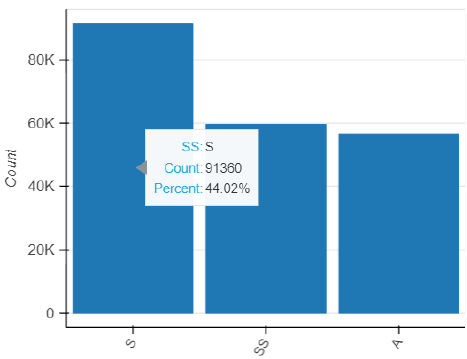
Figure 7. Distribution of network